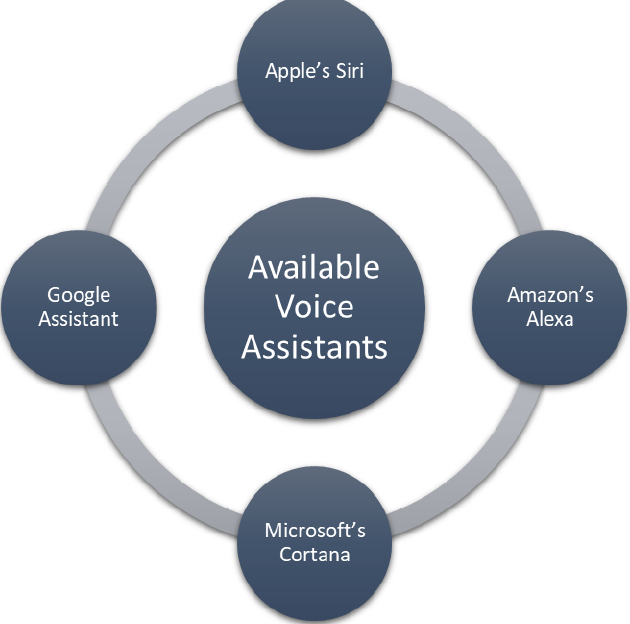
Figure 6. Different software for voice-activated control systems.